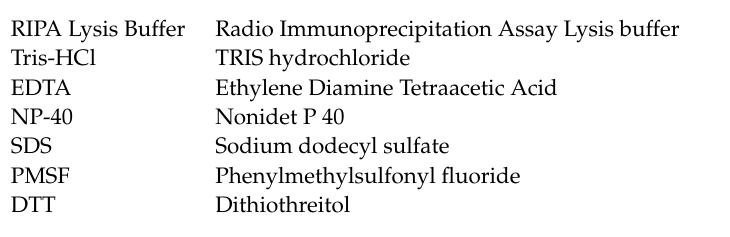
DEPs, Table S3: Setting1 Top 100 Nodes, Table S4: Setting2 Top 100